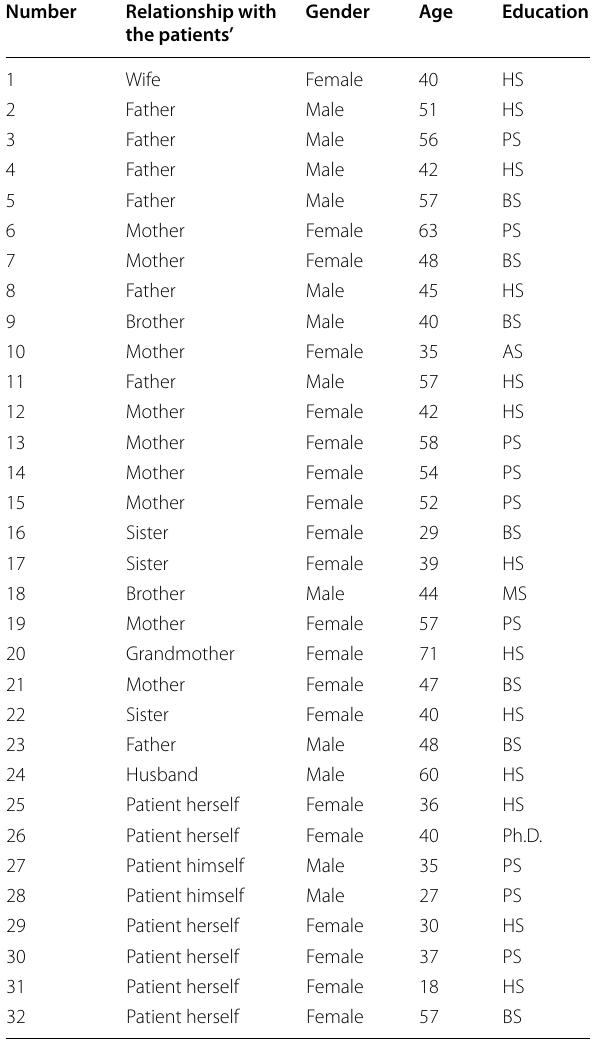
Table 1 Characteristics of